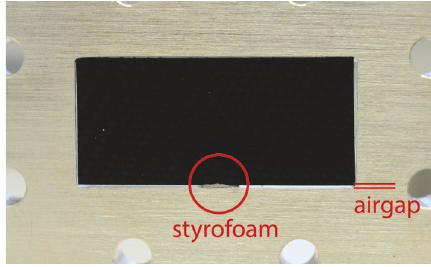
Figure 3: Attachment of a sample with air-gap in the waveguide fixture by clamping a piece of styrofoam into the air-gap, on the example of a twill-CFRP sample with an alignment of 60 ∘